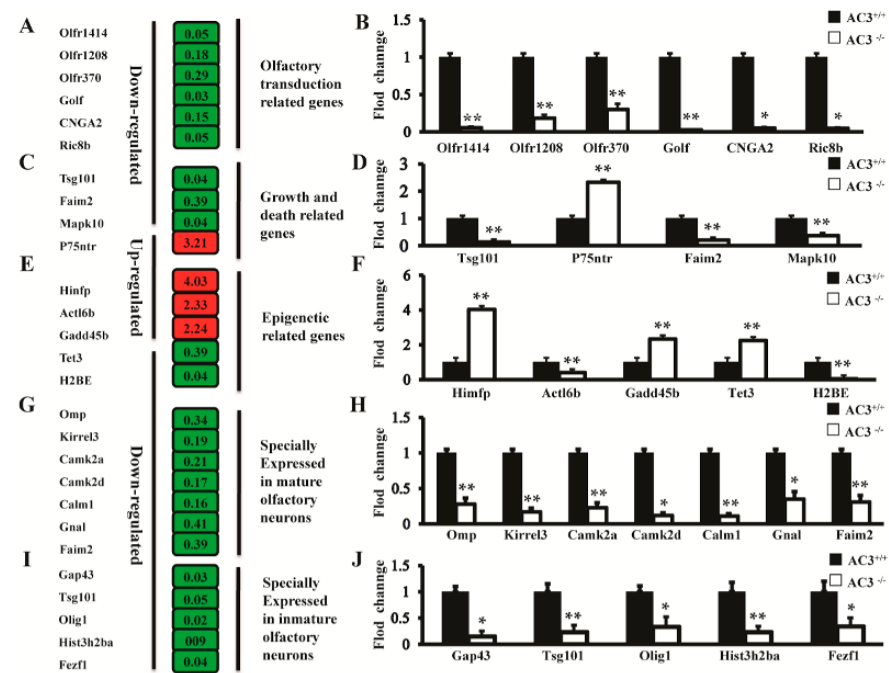
Figure 4. Quantitative RT-PCR verification of the differentially expressed genes in the AC3 − / − and AC3 +/+ mice. ( A ) Differentially expressed genes associated with olfactory signal transduction function identified from the microarray results; ( B ) qRT-PCR verification of the differentially expressed genes associated with olfactory signal transduction; ( C ) Differentially expressed genes associated with cell growth and death identified from the microarray results; ( D ) qRT-PCR verification of the differentially expressed genes associated with cell growth and death; ( E ) Differentially expressed genes associated with epigenetic regulation function identified from the microarray results; ( F ) qRT-PCR verification of the differentially expressed genes associated with epigenetic regulation functions; ( G ) Differentially expressed genes specifically expressed in the mature olfactory neurons identified from the microarray results; ( H ) qRT-PCR verification of the differentially expressed genes specifically expressed in mature olfactory neurons; ( I ) Differentially expressed genes specifically expressed in the immature olfactory neurons identified from the microarray results; ( J ) qRT-PCR verification of the differentially expressed genes specifically expressed in immature olfactory neurons. Note: In the microarray result panel, green represents down-regulated genes and red represents up-regulated genes. The numbers in the red and green boxes represent fold change. n = 3 for each group of mice, experiments are in quadruplicates. All values are expressed as mean ± s.d. * p ≤ 0.05, ** p ≤ 0.01, ANOVA with Student’s t -test.